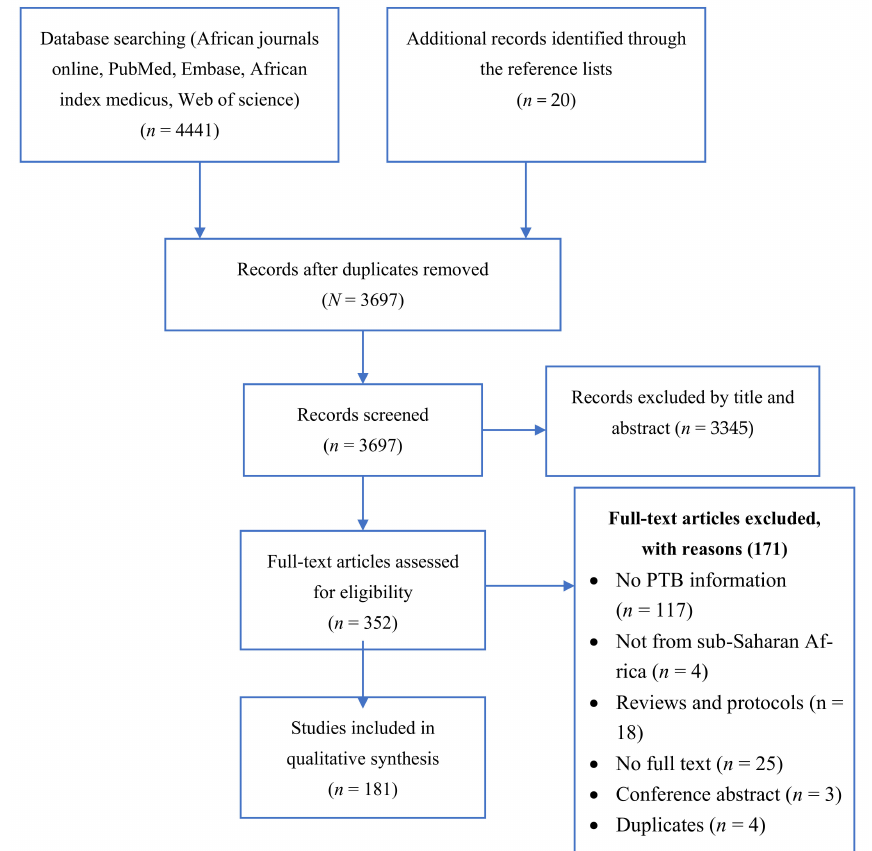
Figure 1. Flow diagram showing the study selection